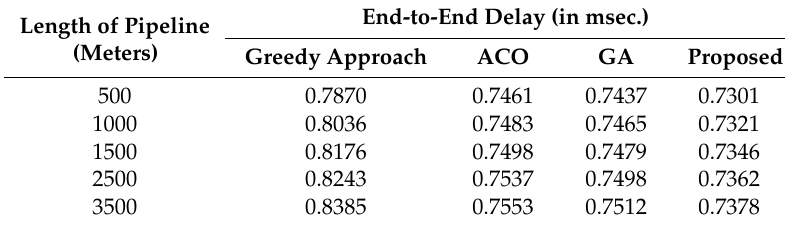
Table 4. Comparion of delay (Range 100 m).